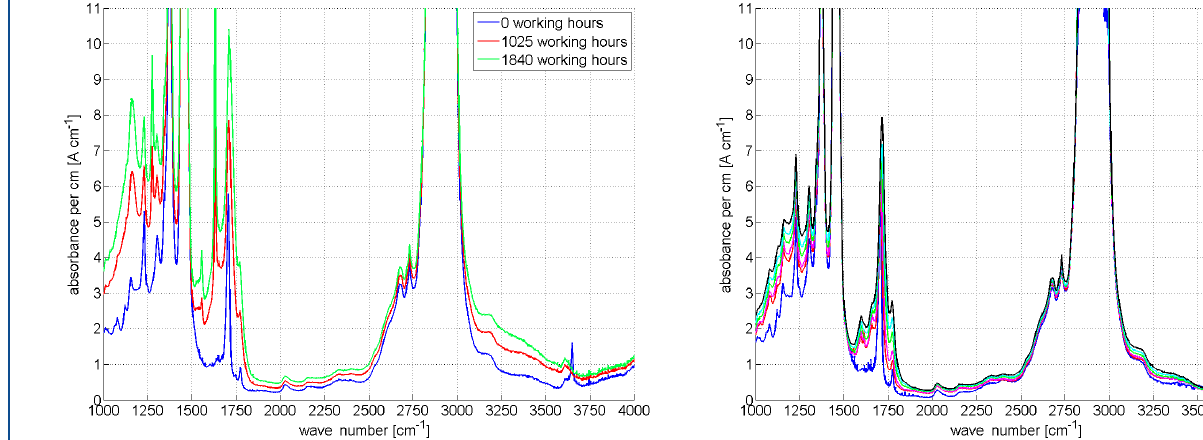
Figure 4. IR spectra of synthetic motor oil (1500mL) artificially aged at 170 ◦ C with 50cm 3 min − 1 air flow over 9